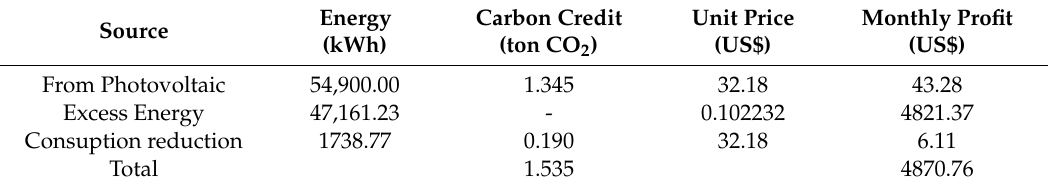
Table 11. Other sources of profit from this smart